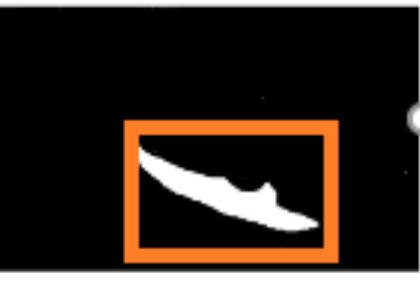
Figure 9: Contours